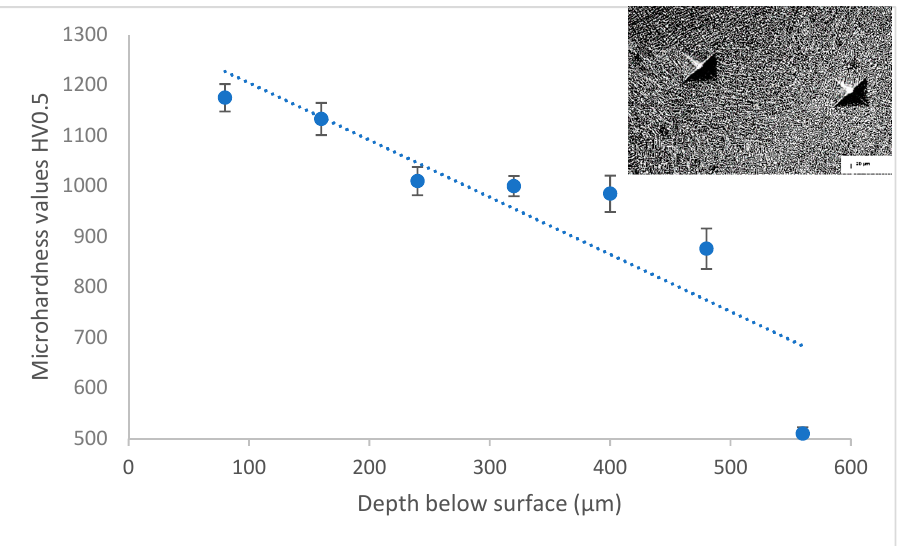
Figure 15. Microhardness distribution through S2-1–3 sample from the hardened layer towards as-cast zone. Error bars represent standard deviation.